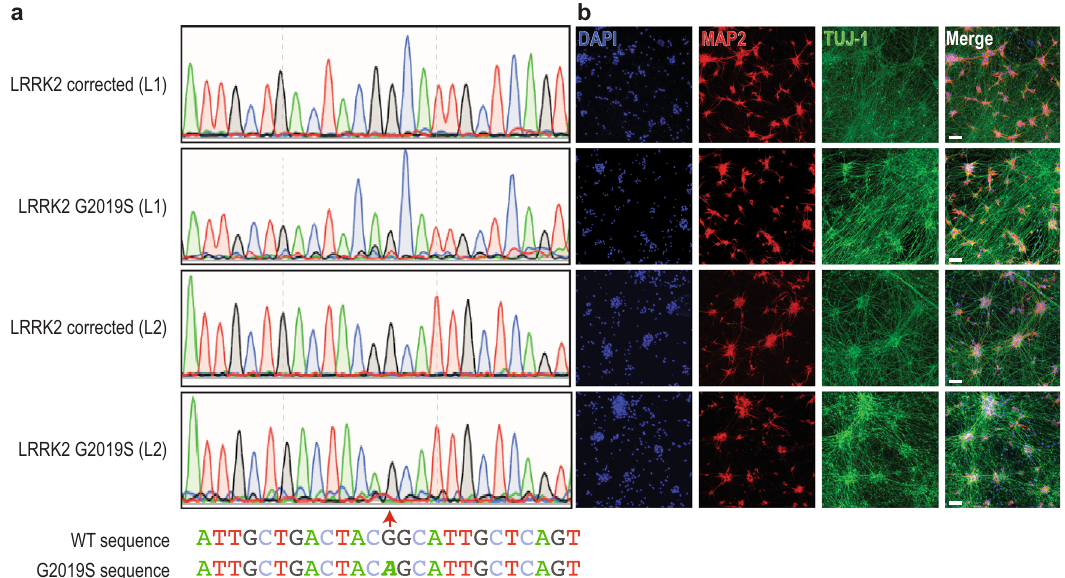
Fig. 1 Characterization of two G2019S-mutant LRRK2 patient neuronal lines and their isogenically corrected versions. a Genomic DNA sequencing showing the presence of heterozygous G2019S mutation (guanine to adenosine transition, red dashed arrow) in two G2019S patient-derived iNs (L1, L2) but not in their isogenically corrected versions. b Representative confocal images of neurogenin-induced iPSCs (iNs) at DIV 14 showing DAPI-stained nuclei in blue and the neuronal markers MAP2 and TUJ-1 in red and green, respectively. White bars: 20 μ m.